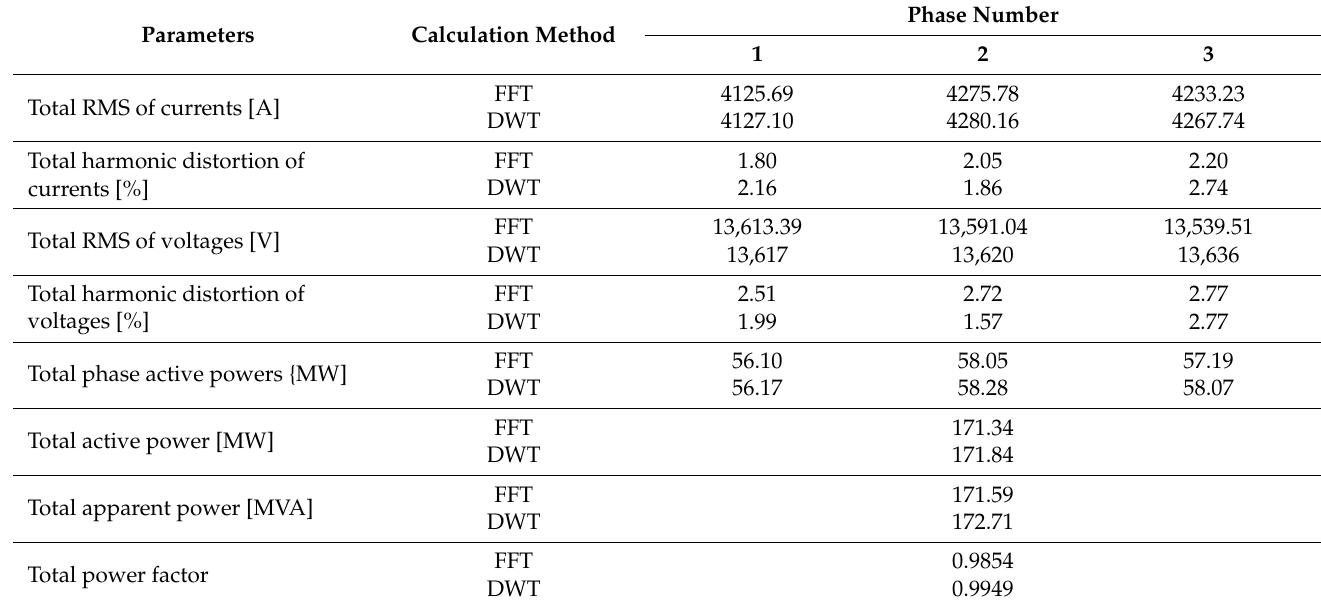
Table 9. Computed Values of Power Quality indices (FFT vs.